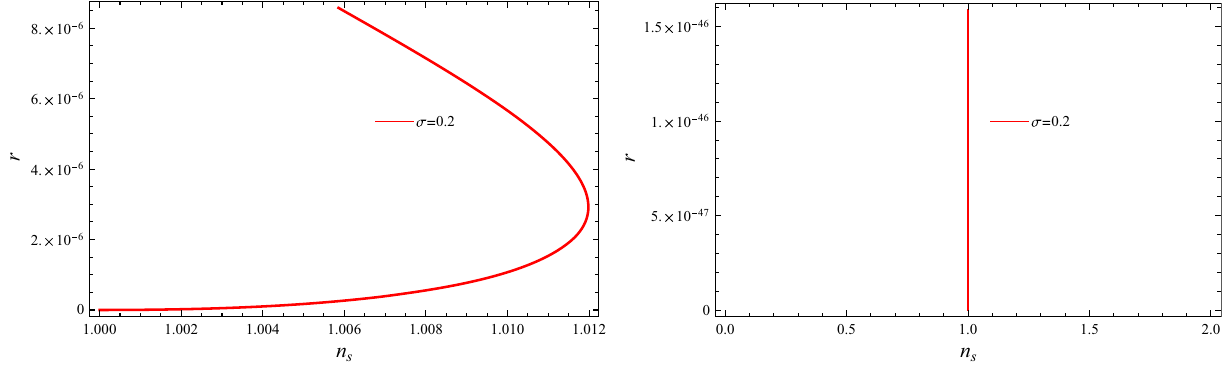
Fig. 14 Plot of r versus n s for GCCG model in weak (left panel) and strong (right panel) dissipative regimes for positive potential with n = − 1